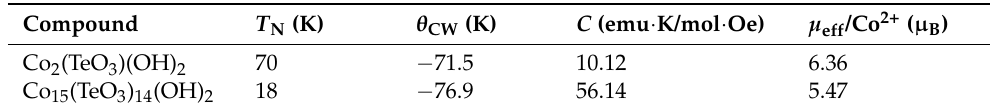
Table 4. Parameters obtained from the M( T ) curves and Curie–Weiss fitting of χ − 1 (T ) . The ZFC/FC peak temperature is given as an estimation of T N